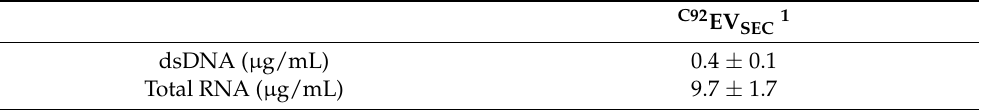
Table 3. Nucleic acid quantification in C92 EV SEC .